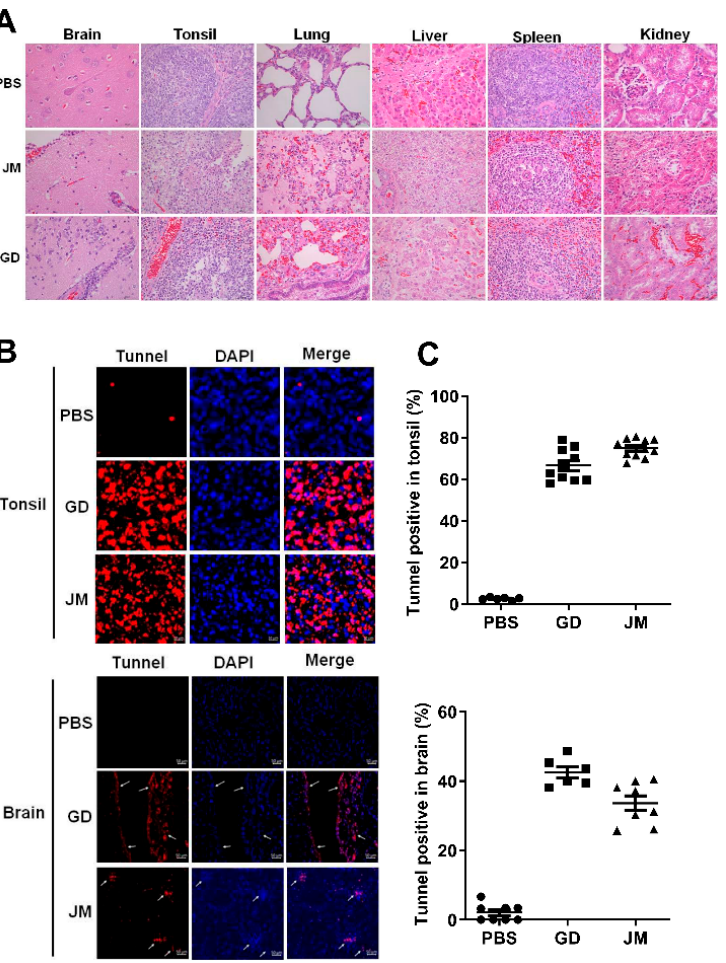
Figure 7. PRV-GD and PRV-JM infection induced tissue injury and cell death. ( A ), Pathological lesions of piglets (H&E staining) that died following infection with PRV-GD or PRV-JM isolate at 10 6 TCID 50 . ( B ), Tunnel solution was used to label the dead cells in the tonsils and brains of piglets. ( C ), The percentage of tunnel-labeled cells was quantified.